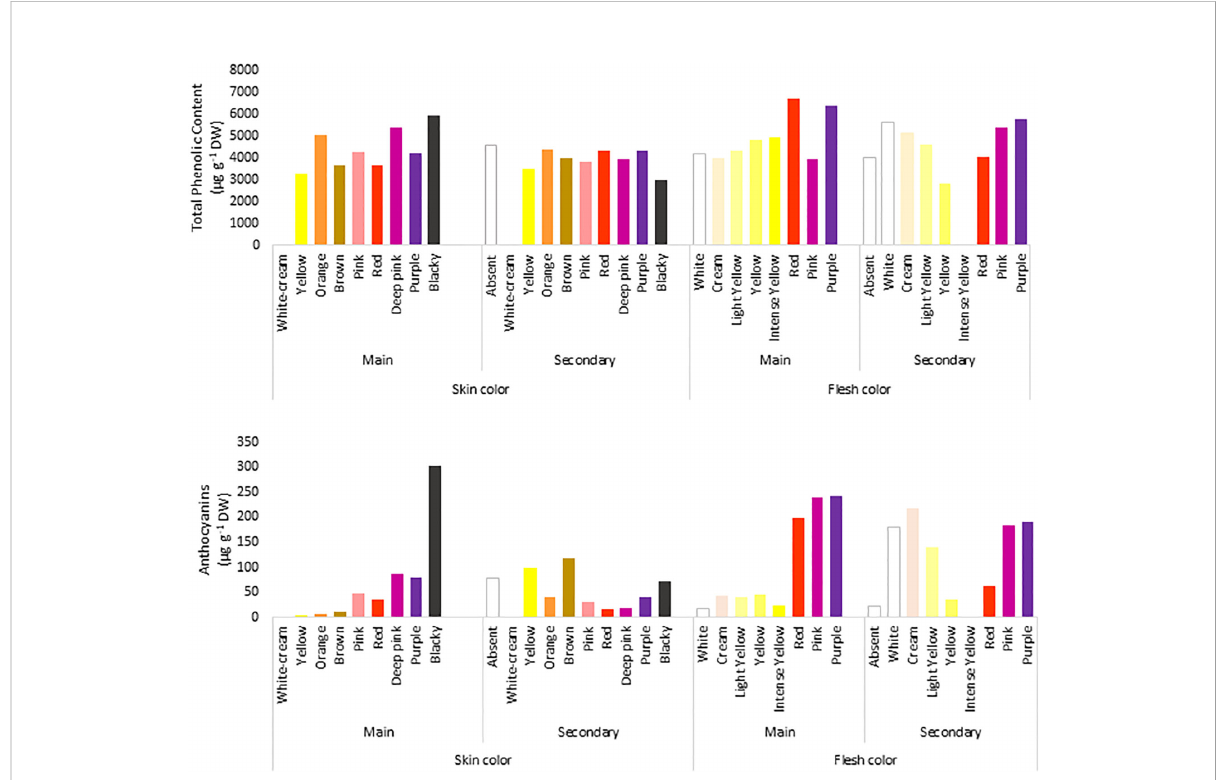
FIGURE 2 Concentration of total phenolic compounds (µg Gallic acid/g DW) determined by Folin – Ciocalteu method (upper panel) and total anthocyanin content (µg/g of cyanidin 3-glucoside) were extracted in ethanol acidi fi ed using Abdel-Aal and Hucl (1999) method (lower panel) in the 290 accessions of the Potato GenBank at the